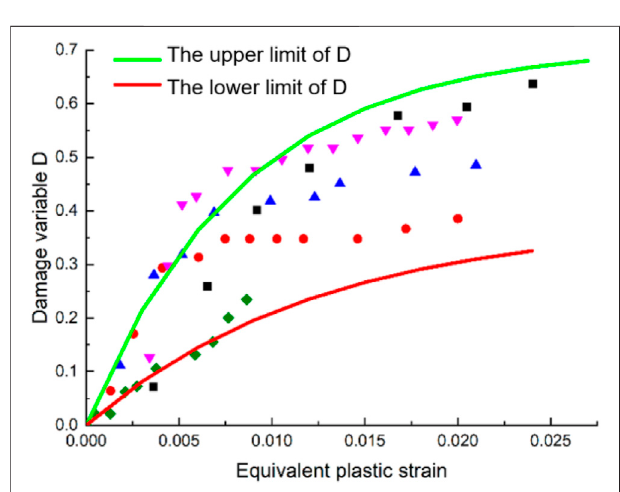
FIGURE 6 | Permeability curves under different pore pressures.